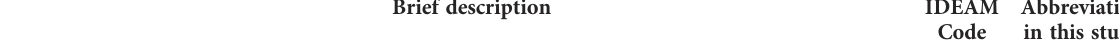
TABLE 2 Drainage basins within the study area. The last column (on the right) provides an arbitrary abbreviation that will be used along this study to refer to these